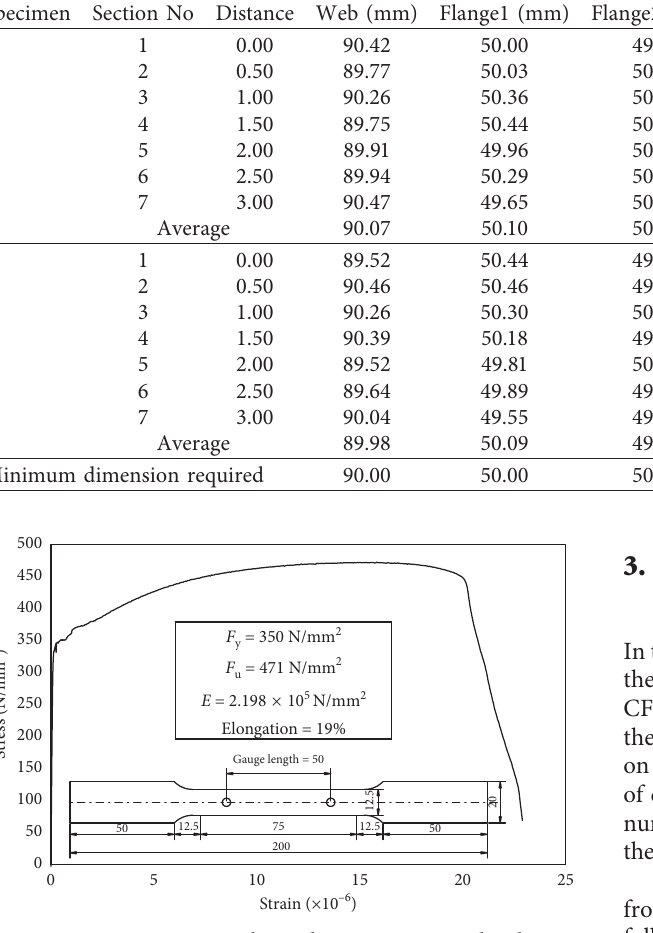
Figure 1: Stress-Strain plot and tension coupon